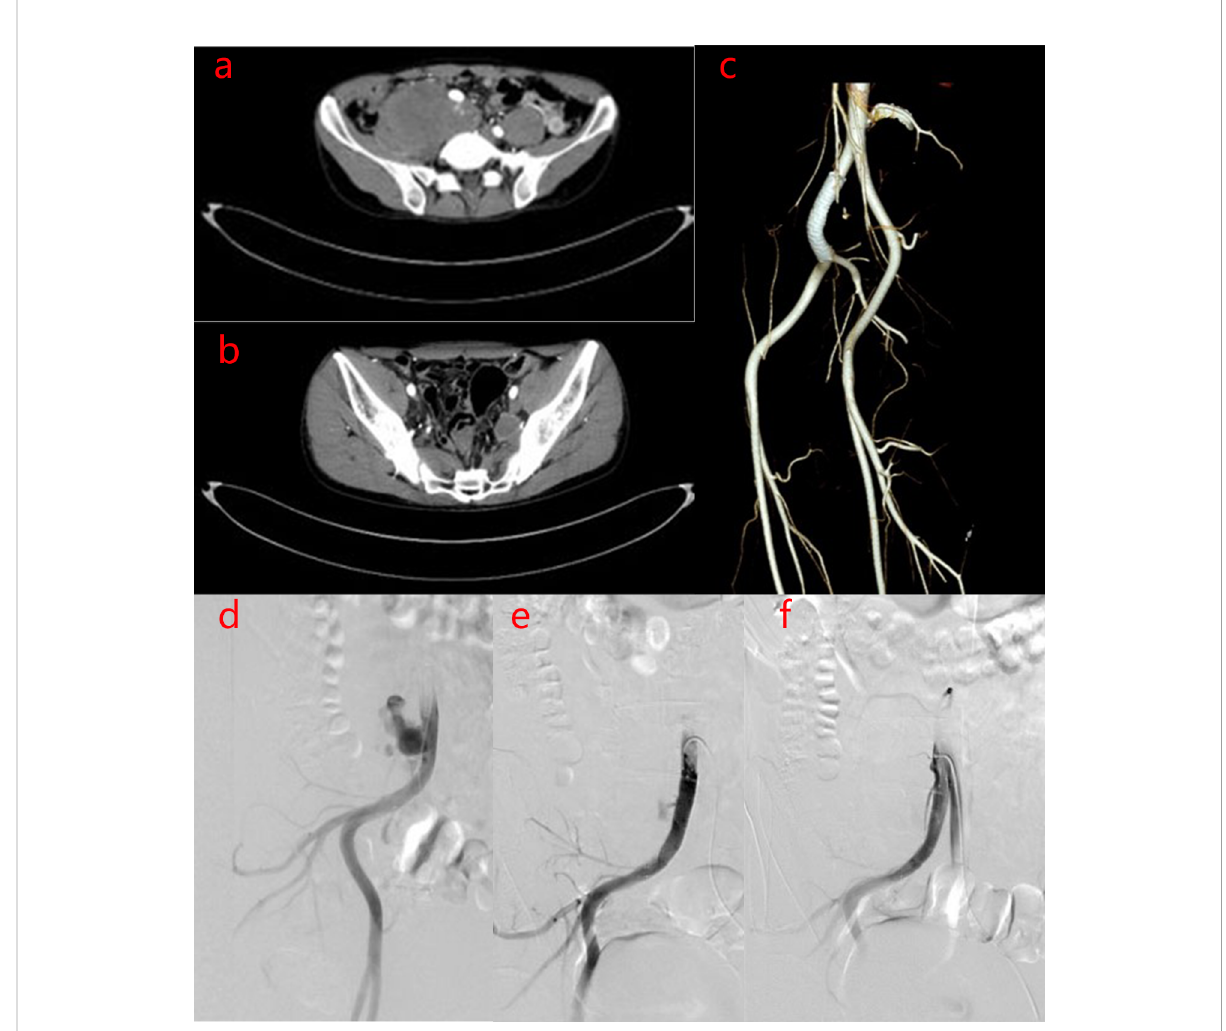
FIGURE 4 Imaging manifestations of pseudoaneurysm of the right CIA before and after covered stent implantation. (A – C) . After 27 months of bare stent implantation, abdominal CTA showed the following fi ndings: The size of the pseudoaneurysm was obviously increased compared to that post- operation, because the contrast agent continuously fl ows into the cavity of the pseudoaneurysm. However, there was no contrast agent in the left IIA pseudoaneurysm area. (D – F) . After covered stent implantation, DSA of the right inferior vena cava showed the following fi ndings: There was less contrast agent blowing into the cavity of the pseudoaneurysm of the right CIA and the size of the pseudoaneurysm was